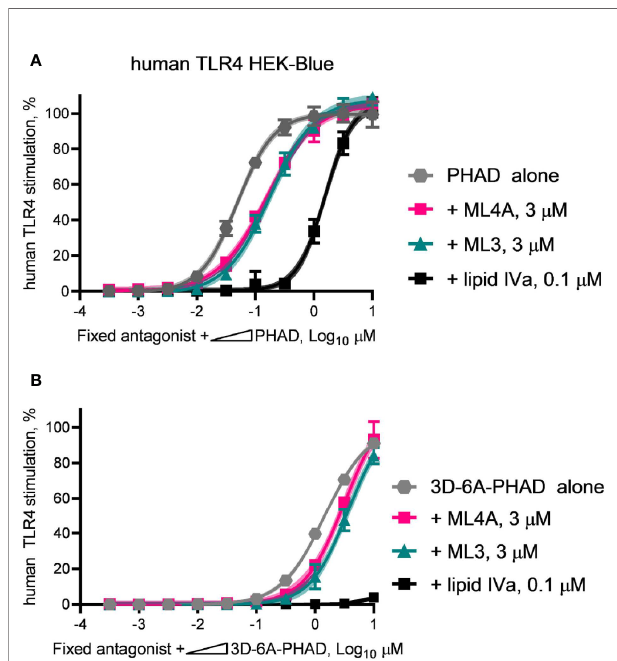
FIGURE 7 | ML3 and ML4A function as competitive antagonists of human TLR4. MPL adjuvant ® components ML3 and ML4A were tested for competitive antagonism of human TLR4 using reporter cells. The agonists (A) PHAD and (B) 3D-6A-PHAD were diluted in half-log steps from a peak concentration of 10 m M in a mixture containing a fi xed concentration of ML3 (3 m M), ML4A (3 m M) or Lipid IVa (0.1 m M). Values shown are averages ± SD of secreted alkaline phosphatase from two independent experiments, each performed in duplicate or triplicate and normalized by setting 100% = PHAD or 3D-6A-PHAD alone (3 m M). Shaded regions indicate 99% con fi dence intervals within which the true population means should occur 99% of the time. Agonist curves in the presence of a fi xed amount of ML3 or ML4A reached the same top dose plateaus as for agonist alone indicating both are competitive antagonists of human